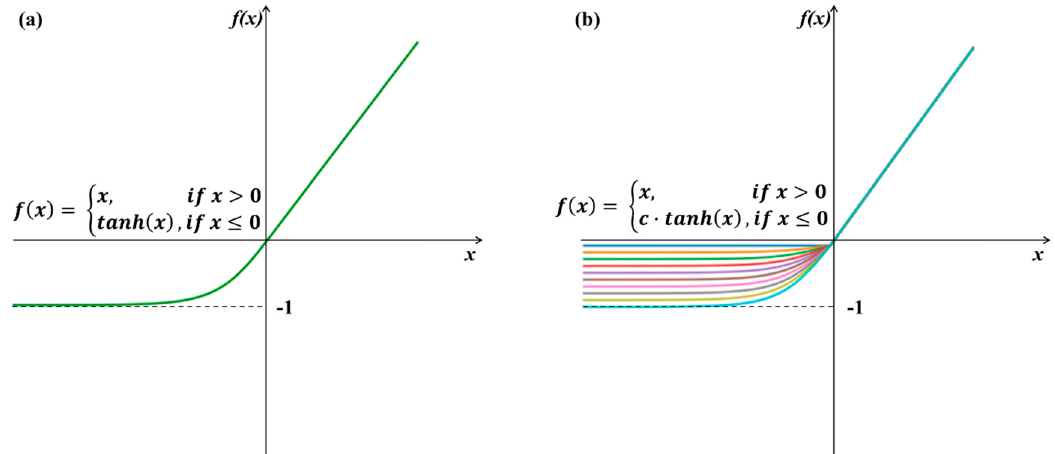
Figure 3. Shapes of the activation functions of the extreme learning regression (ELR) method. The left c*TanhRe function ( b ); c is a constant ranging from 0 to1; the differently colored curves in the right figure represent various activation functions when employing different c values.